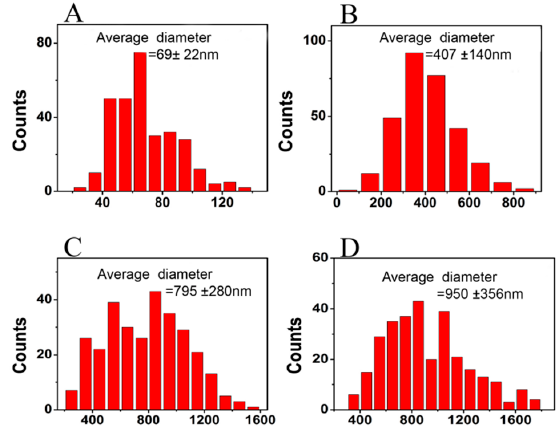
Figure 2. The fiber diameter distribution of zein ( A ); zein/gelatin-1 ( B ); zein/gelatin-2 ( C ); and zein/gelatin-3 ( D ) electrospun nanofibers.